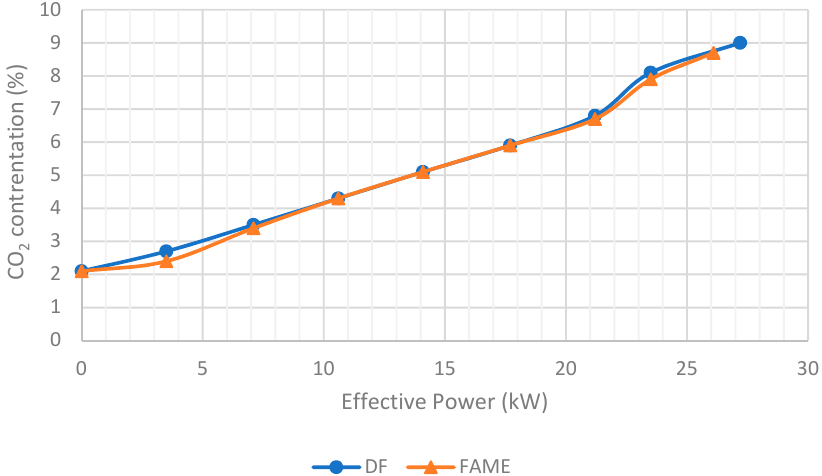
Figure 6. CO 2 emission level in the exhaust gas as a function of the effective power of the S-4003 engine, at an engine speed of 1600 rpm.